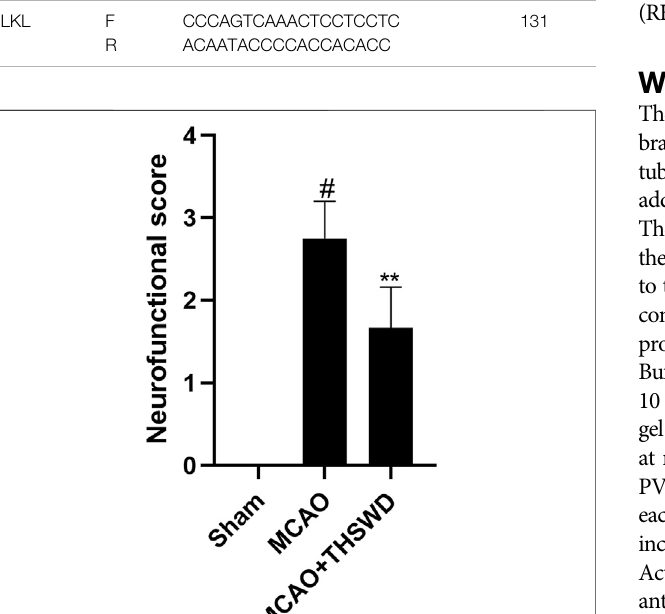
Frontiers in Pharmacology |